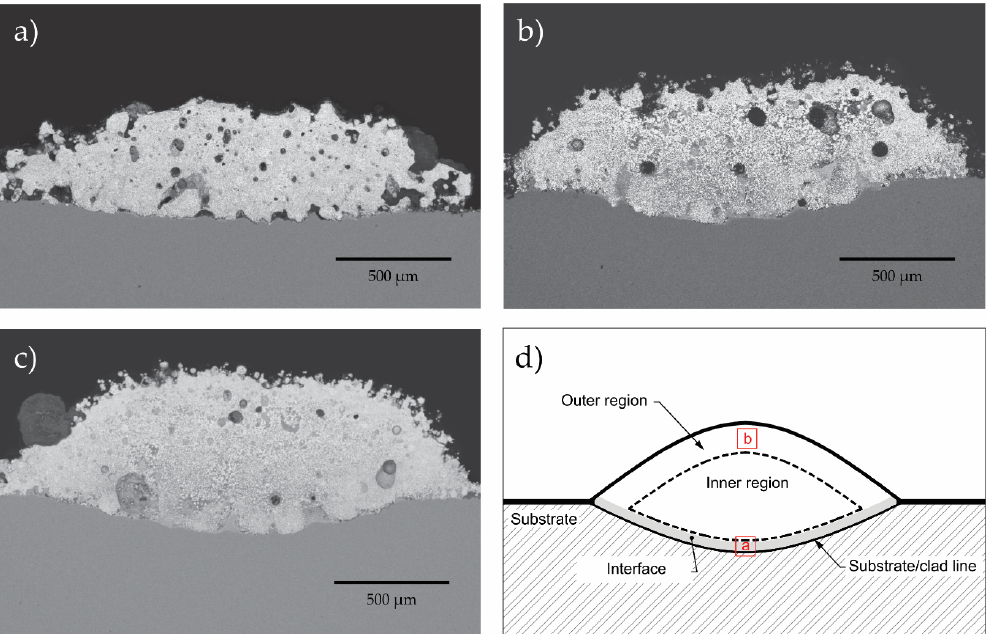
Figure 3. Cross-section macrographs of single-cladding samples: ( a ) E a24 , ( b ) E a32 and ( c ) E a39 , ( d ) schematic indicating various regions within the single-cladding.